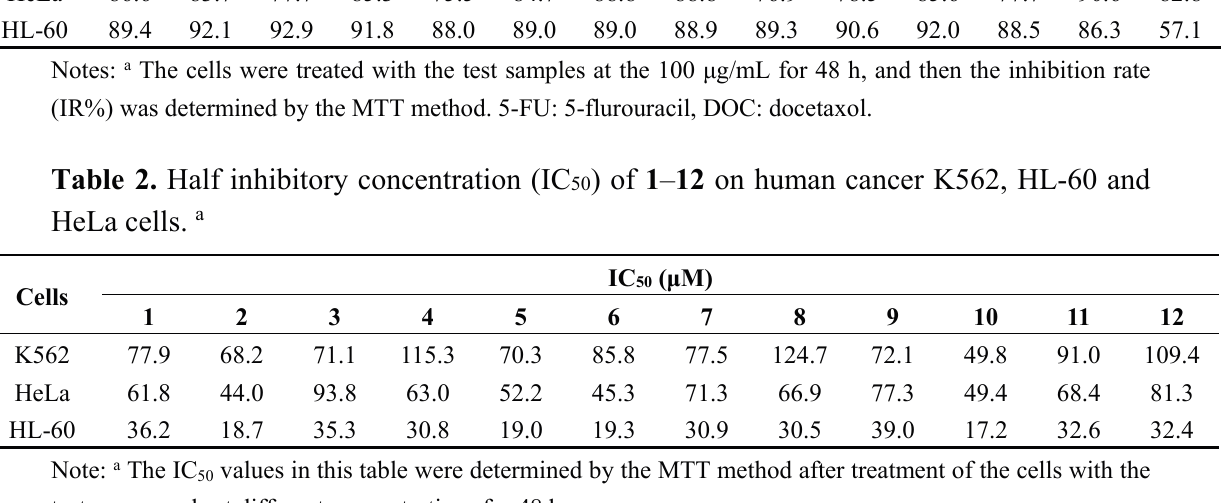
Table 1. Inhibition rate (IR%) of 1 – 12 on human cancer K562, HL-60 and HeLa cells at 100 μ g/mL. a Cells